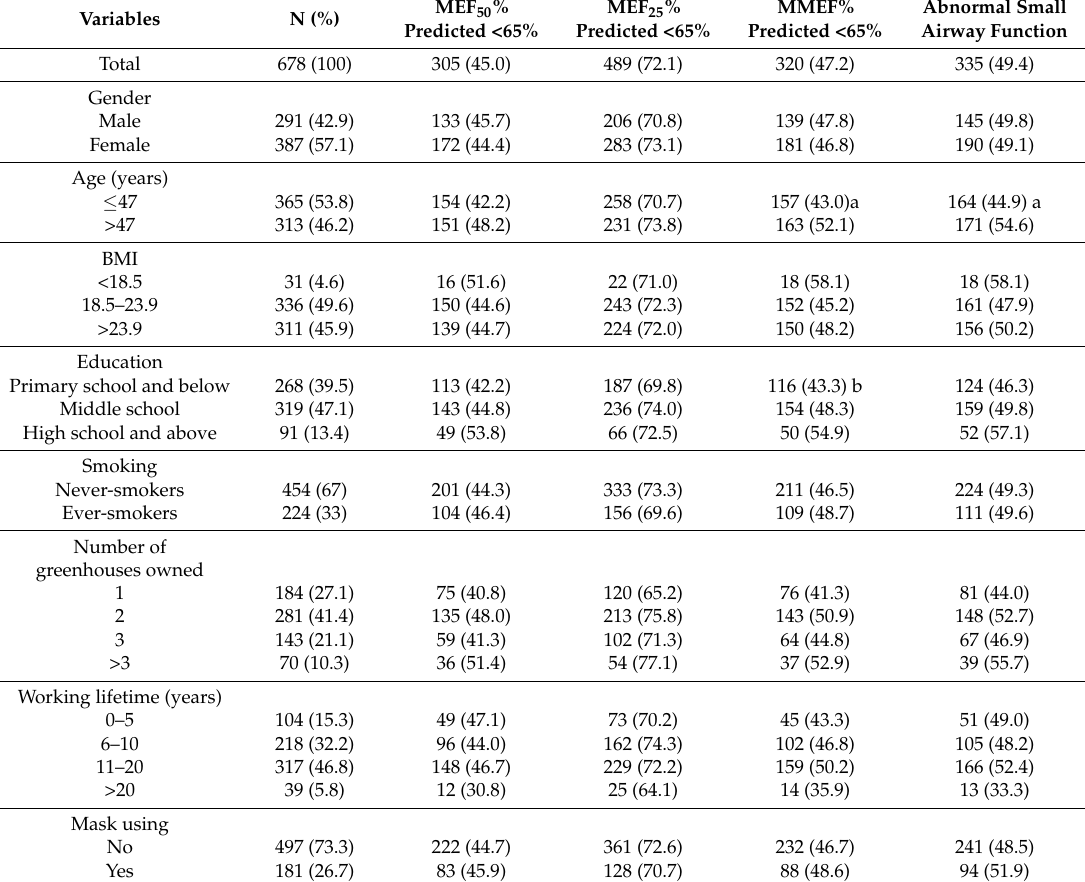
Table 5. Positive rates of abnormal small airway function among greenhouse